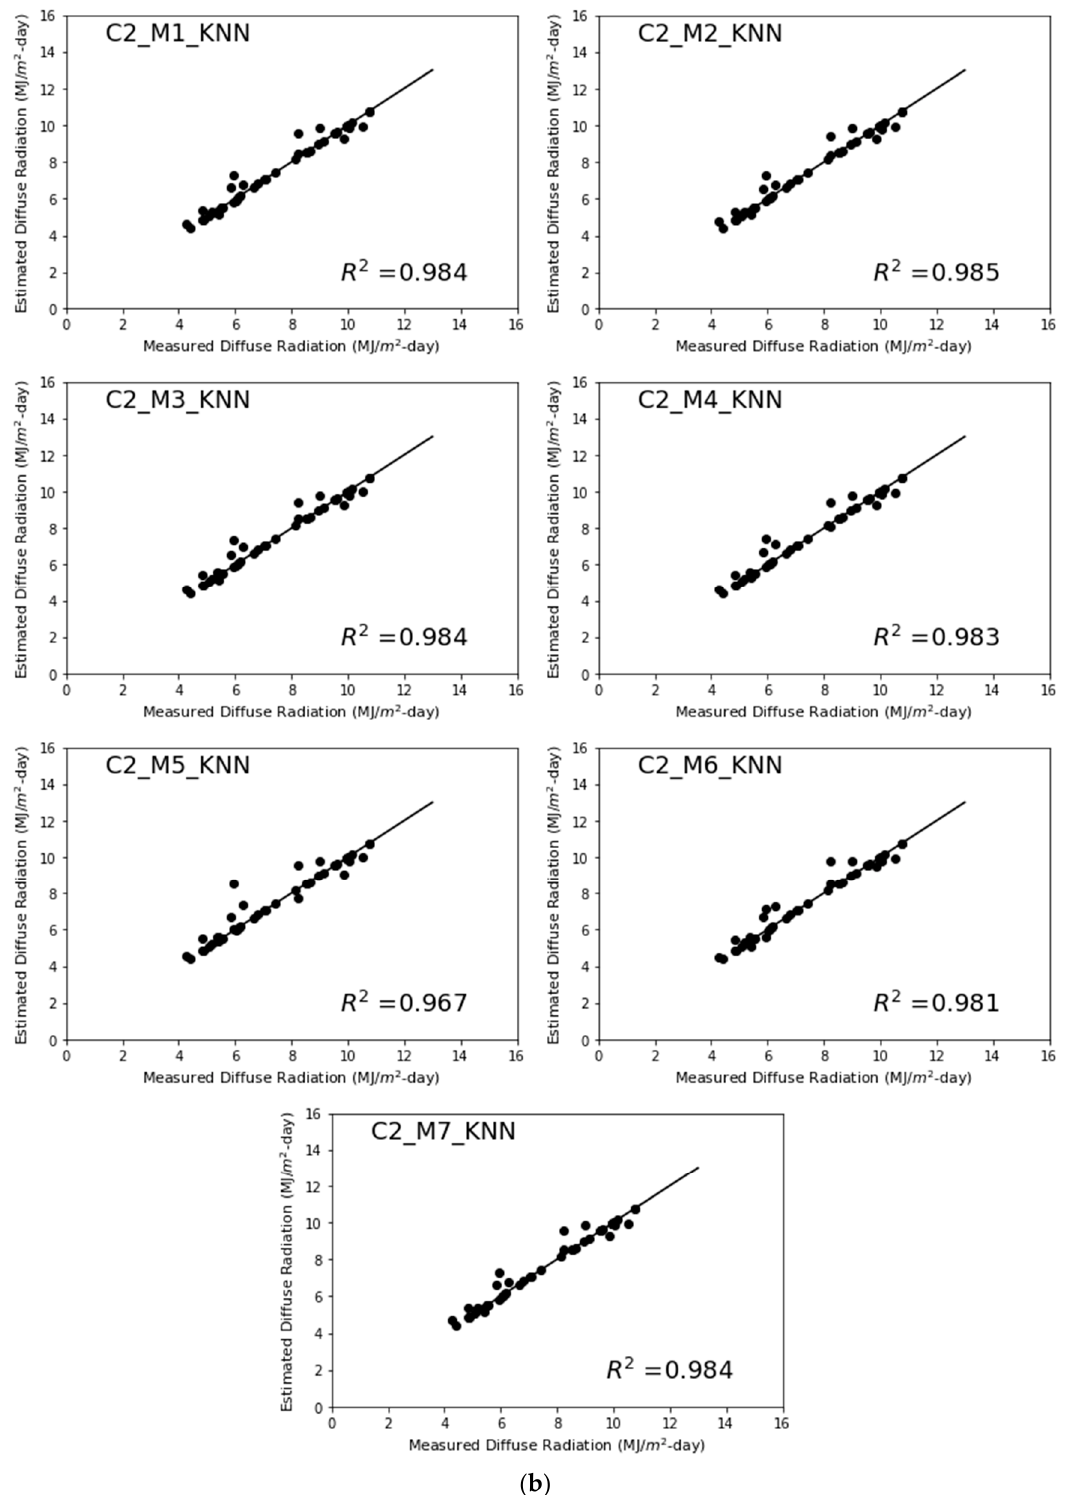
Figure 8. ( a ) Plot depicting predicted and measured DSR for subtropical humid climate (Category 1). ( b ) Plot depicting predicted and measured DSR for subtropical humid climate (Category 2).